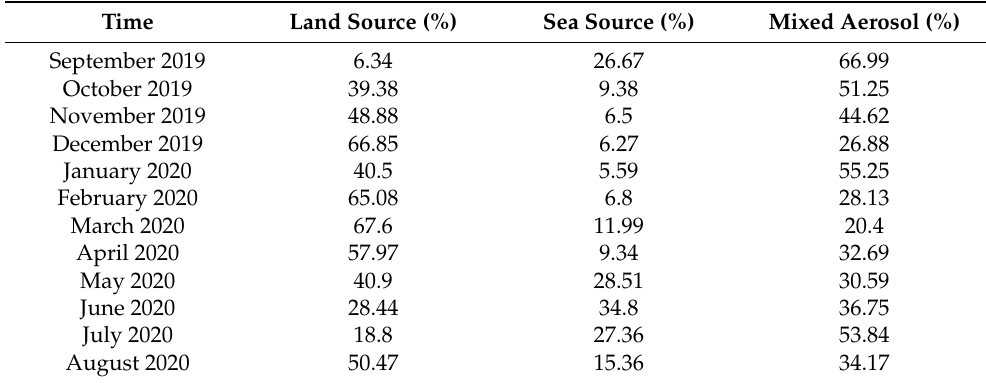
Table 3. Aerosol source percentage results from clustering of backward trajectories. Time Land Source (%) Sea Source (%) Mixed Aerosol